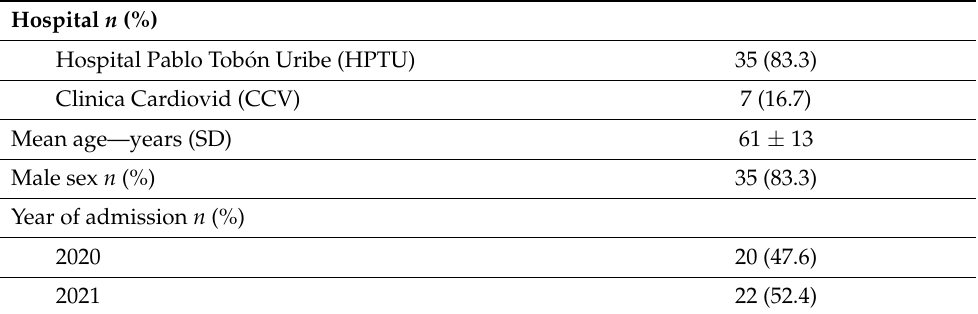
Table 1. Demographics, clinical characteristics, and outcomes of patients with COVID-19 on invasive mechanical ventilation with necrotizing